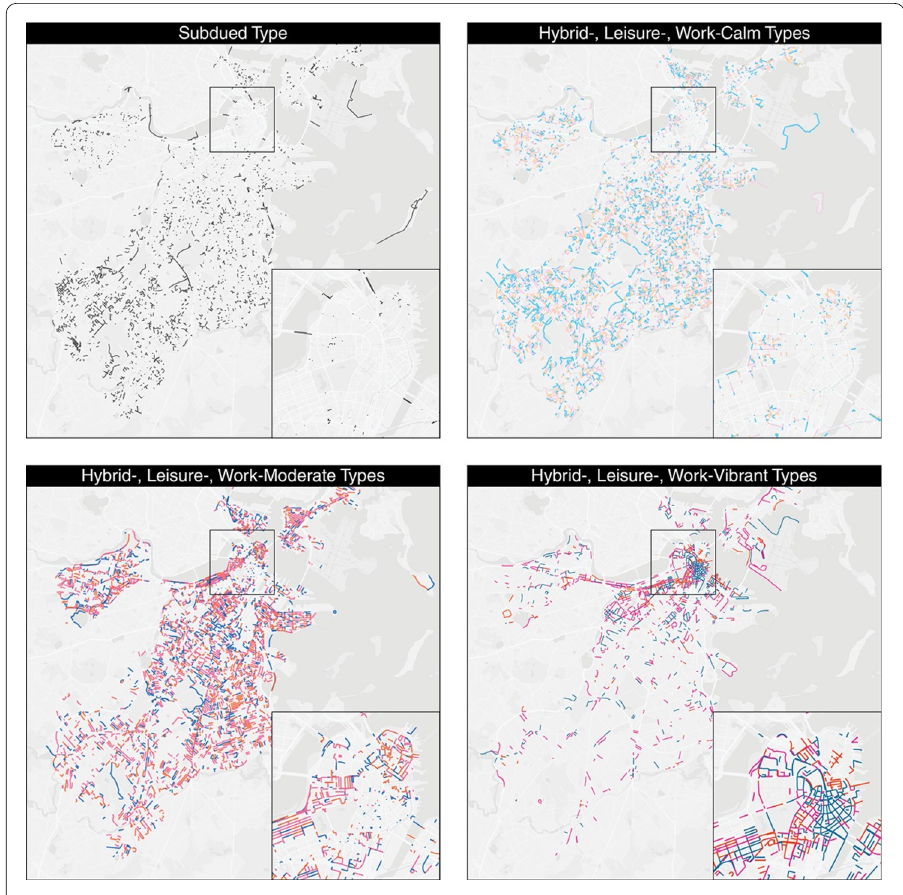
Figure 6 Spatial distribution of ASTs